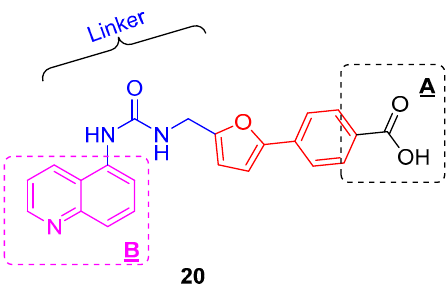
Figure 2. Chemical structure of 20 and the focus of structural modifications.